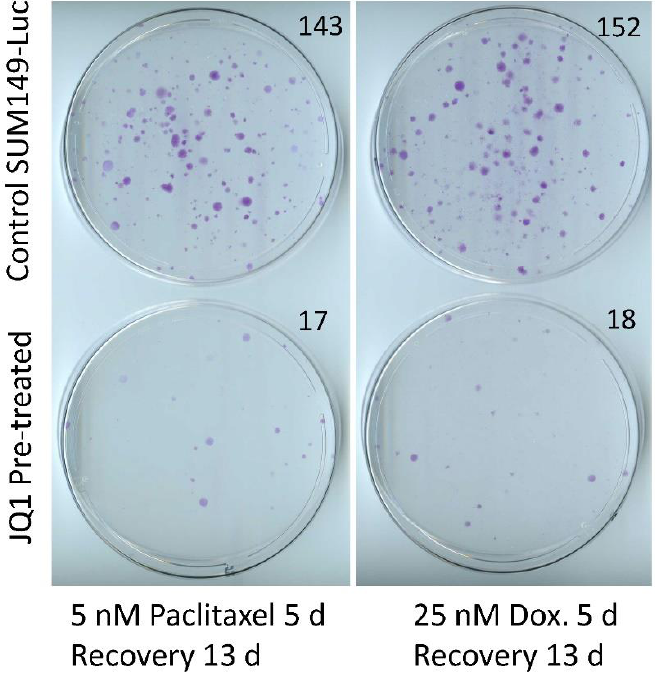
Figure 3. Pretreatment with JQ1 sensitizes SUM149-Luc cells to chemotherapeutic drugs. After 6 days of treatment with 1 µM of JQ1, we allowed the surviving cells to recover in a drug-free medium for 9 days, trypsinized them, and plated them into fresh culture dishes. We then treated the cells with 5 nM of paclitaxel (middle panel) or 25 nM of doxorubicin (Dox, right panel) for 5 days and then let them recover and grow into colonies for 13 days before staining them with crystal violet. These images show that pretreatment with JQ1 markedly decreased the number of colonies. Passage number in cell culture: passage 4.